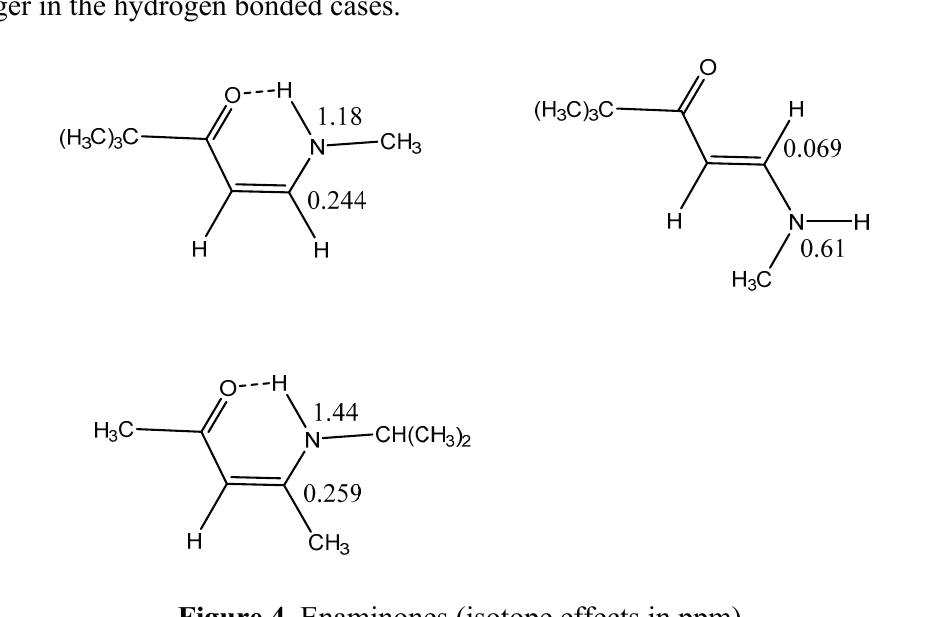
Figure 4. Enaminones (isotope effects in